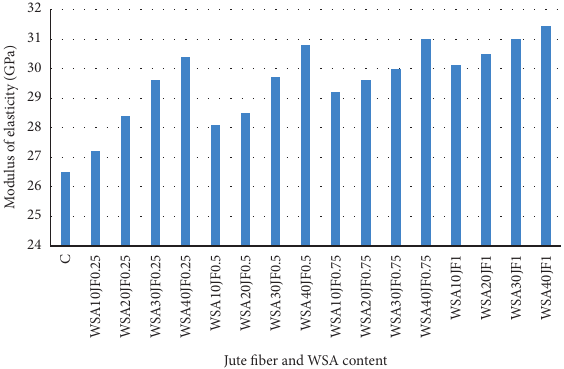
Figure 11: Modulus of elasticity of mixture containing jute fiber and WSA.